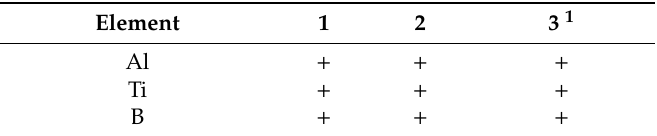
Table 4. Quantitative elemental analysis elemental analysis of Al-Ti-B powder particle cross section after 900 s planetary milling.